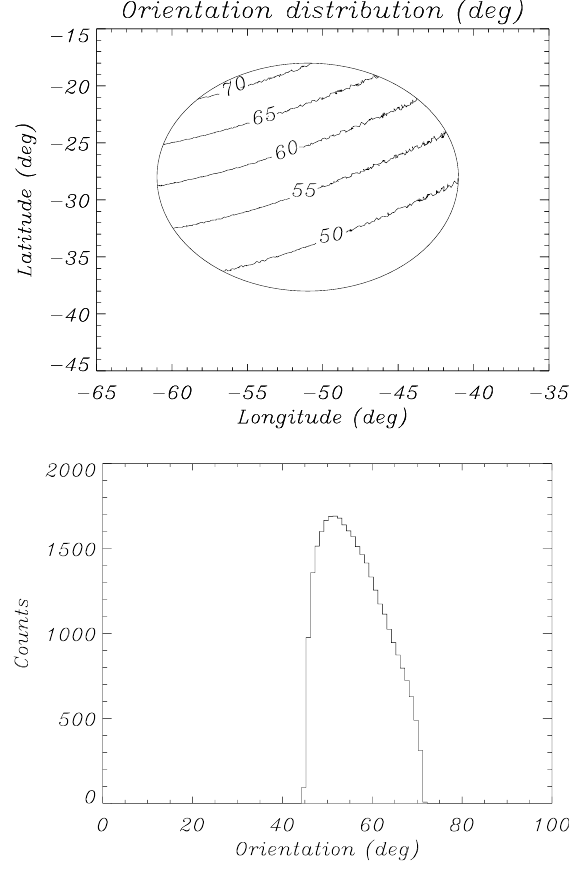
Fig. 7. (a) Geographical positions within a 10 ◦ range around the position of peak flux defined herein as the heart of SAA throughout this paper and contour of constant orientation angle β . (b) His- togram of orientation angles β sampled by the Oersted/CPD within the SAA